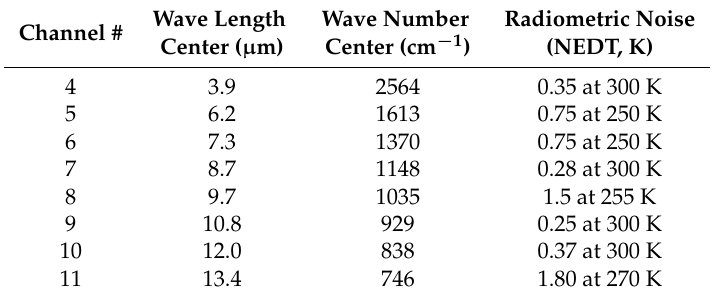
Table 1. SEVIRI infrared channels and radiometric noise performance in NEDT (noise Equivalent Difference